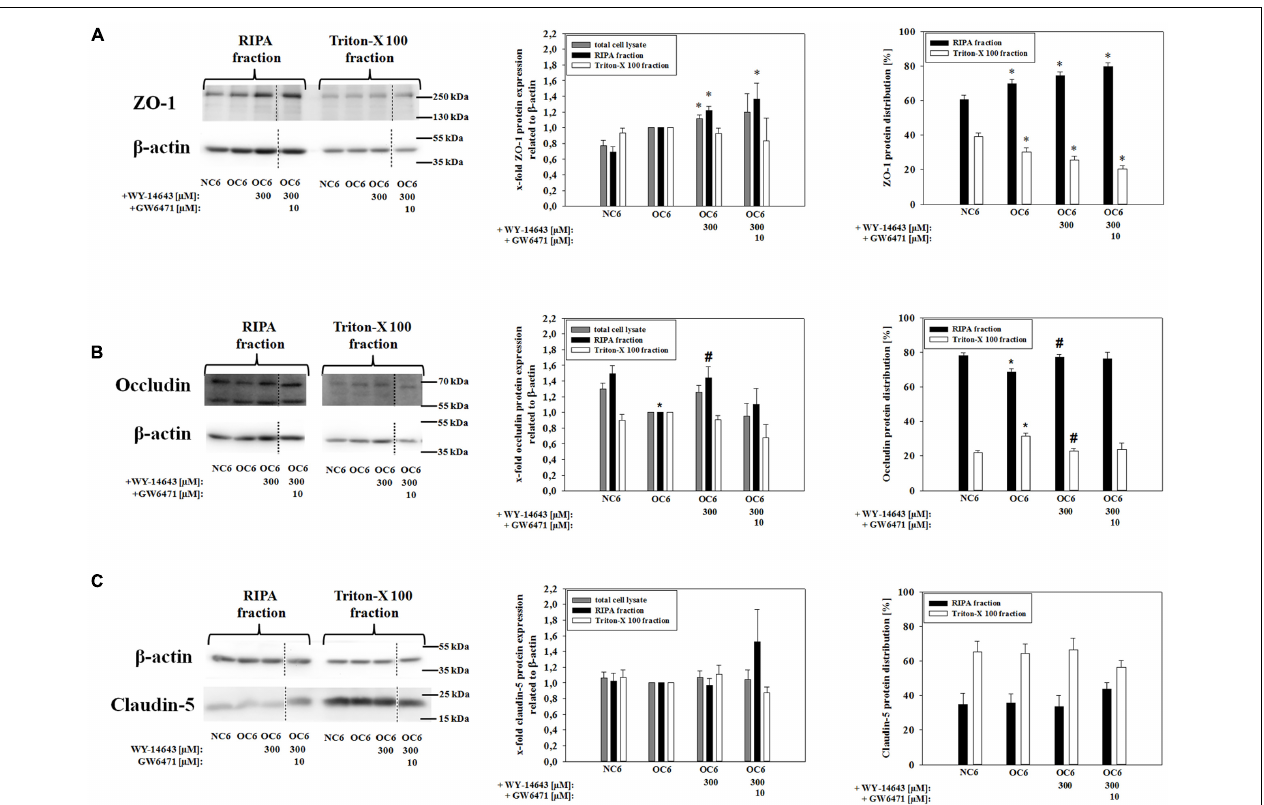
FIGURE 2 | Influence of WY-14643 and PPAR α antagonist GW6471 on effects of OC6 treatment on the protein expression of tight junction proteins ZO-1, occludin and claudin-5 of cerebEND cells. OC6 treatment of cerebENDs accords to 4 h OGD treatment with medium supernatants derived from 4 h OGD-treated C6 cells, whereas NC6 treatment means cerebEND cells incubated for 4 h under normoxic conditions with medium supernatants of 4 h normoxic treated C6 cells. Results for ZO-1 (A) , occludin (B) and claudin-5 (C) were displayed. Densitometric analyzed protein expression of total cell lysates were compared to RIPA and triton-X 100 fractions. Moreover, protein distributions [%] between RIPA and triton-X 100 fractions were presented. Values were related to β -actin and according representative western blot images are depicted. Dotted lines indicated cuts of images of the same blot due to presentation reasons of selected bands. Statistical significance was labeled with ∗ vs. NC6 and # vs. OC6 ( p < 0.05). Data are presented as means ± SEM ( n =